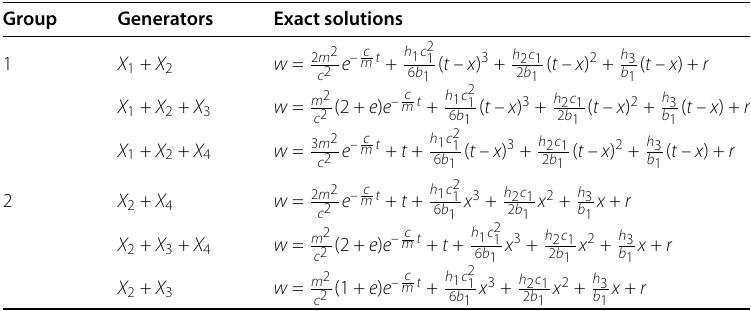
Table 3 The exact solutions to the quintic nonlinear equations of motion Group